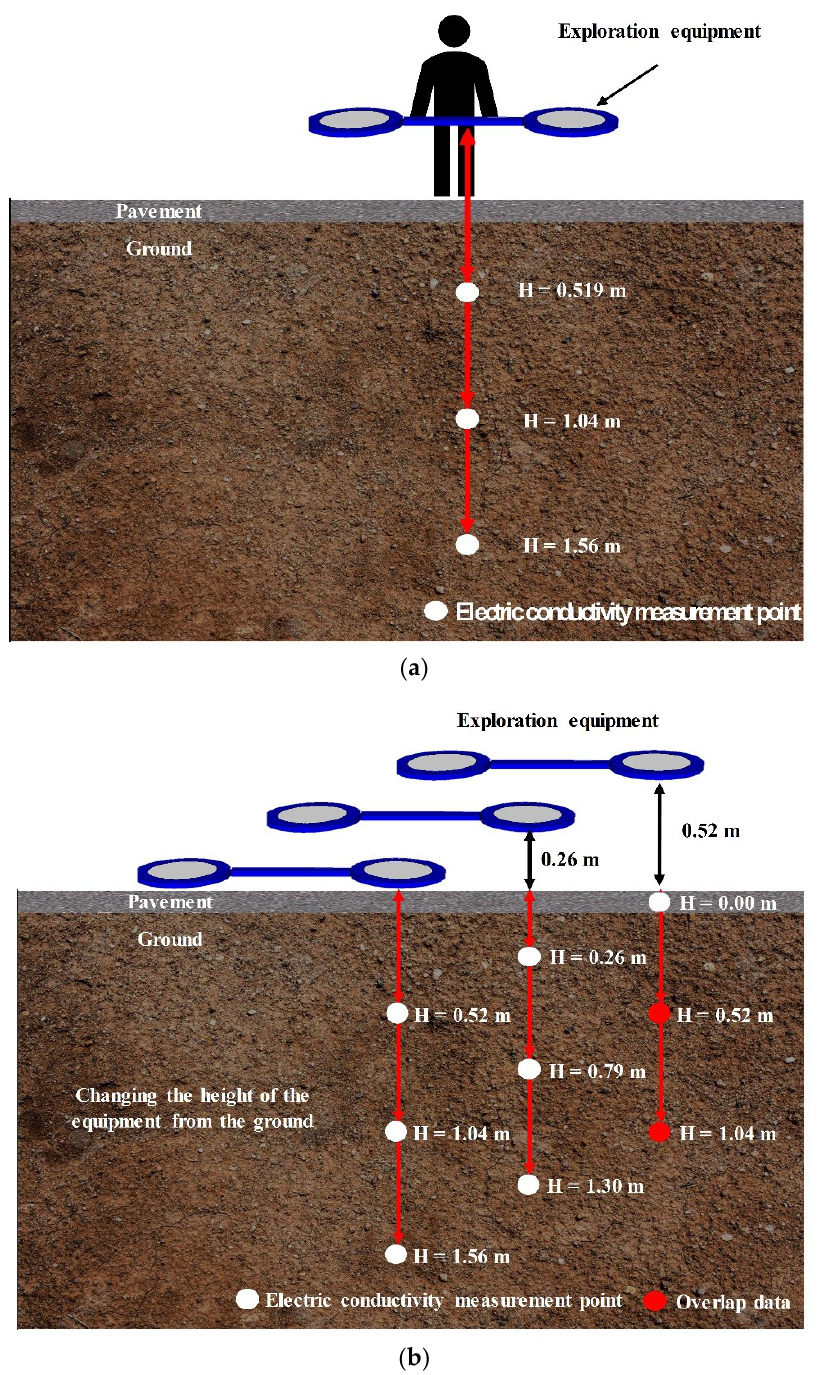
Figure 3. Increase in measurement depth by repeating the survey at different heights. ( a ) Original measured depths; ( b ) increased measurement depths by superposition.